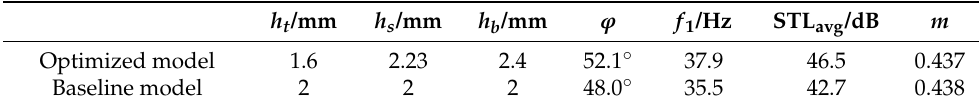
Table 6. Optimization results in high-frequency range with water cavities.